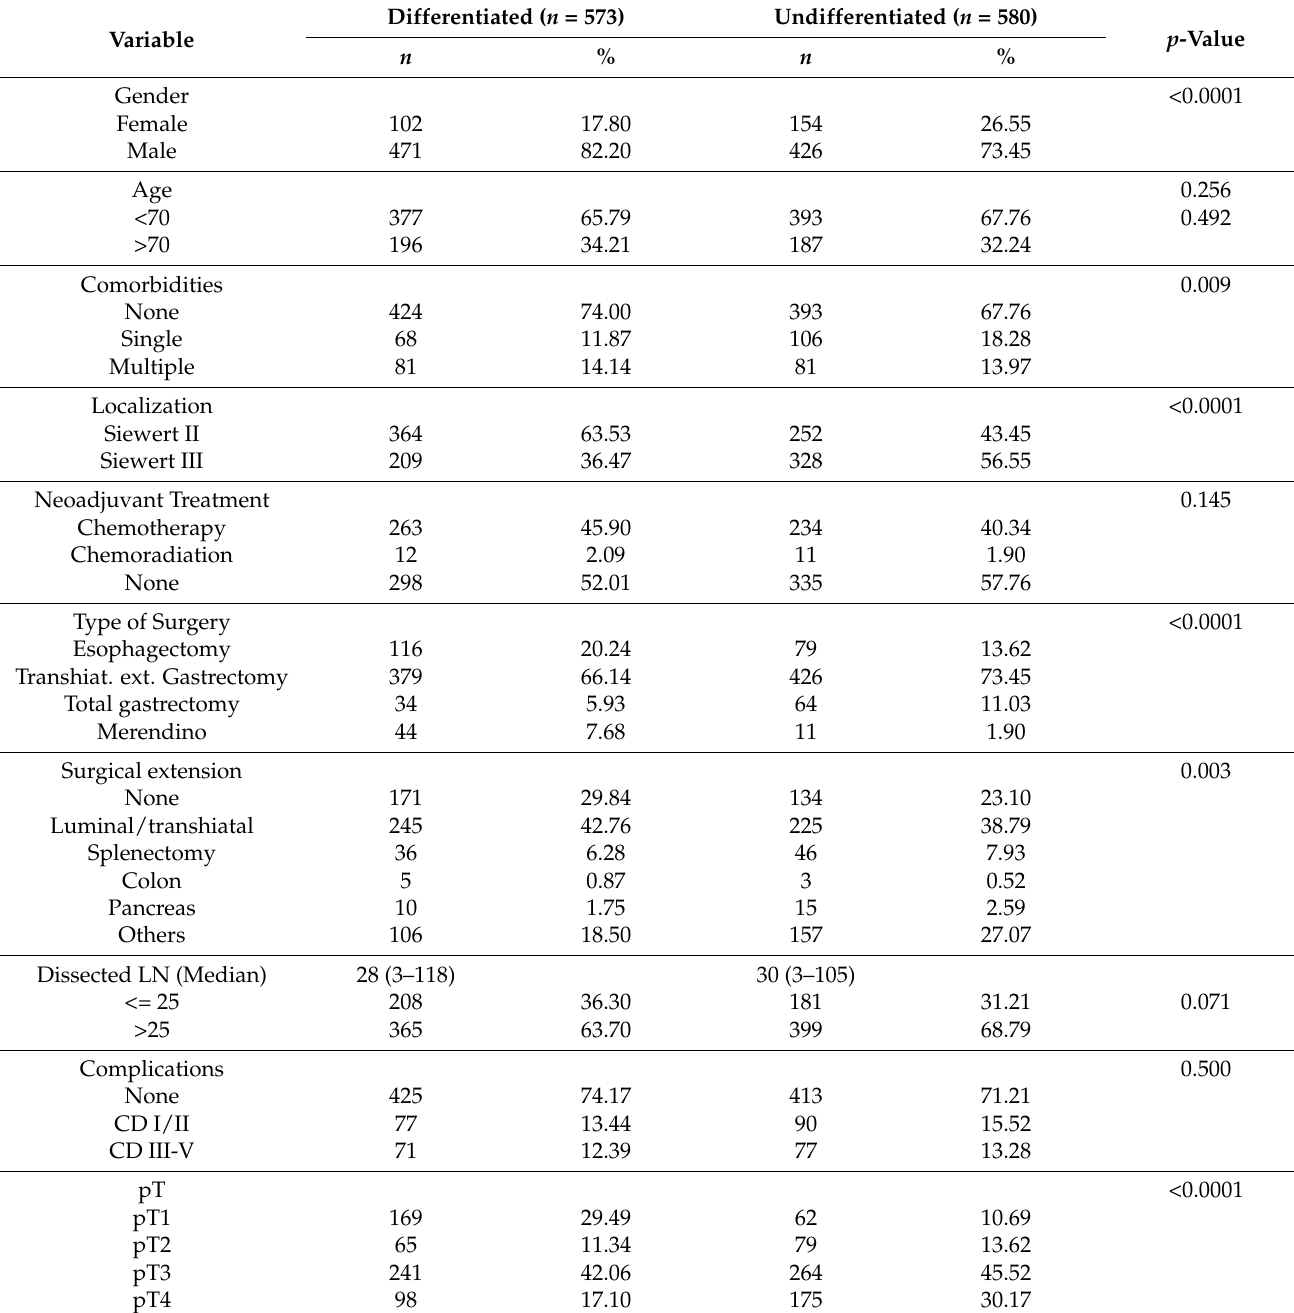
Table 3. Baseline characteristics for patients with differentiated/undifferentiated histotypes before propensity score matching